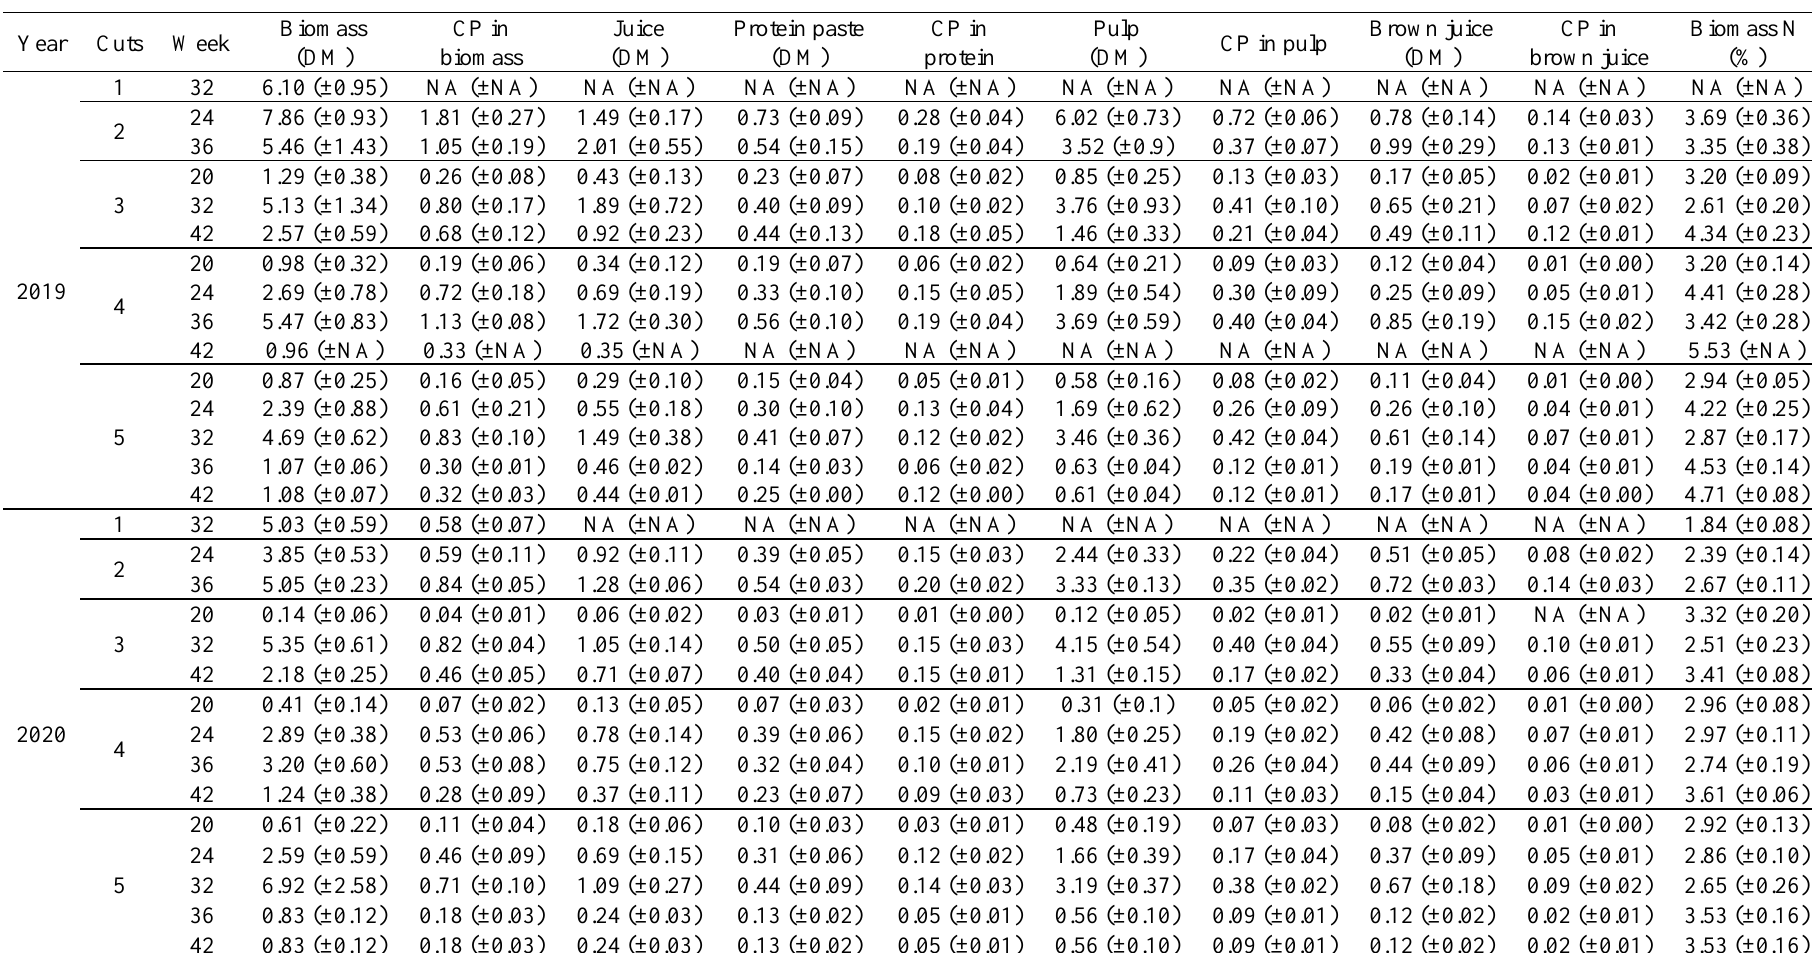
Table A2. Average yields for biomass and all fractions resulting from green biorefinery, including the respective crude protein (CP) yields, for Festuca arundinacea (RCG) under harvest frequencies of one to five annual cuts, for each harvest occurrence as indicated by calendar week and for both assessed years. Standard error is given in brackets. All values are expressed in t ha -1 yr -1 (DM or CP) except for nitrogen (N) (%). Missing data (NA = not available) could not be determined due to technical difficulties. Values for 2019 are taken from Nielsen et al .